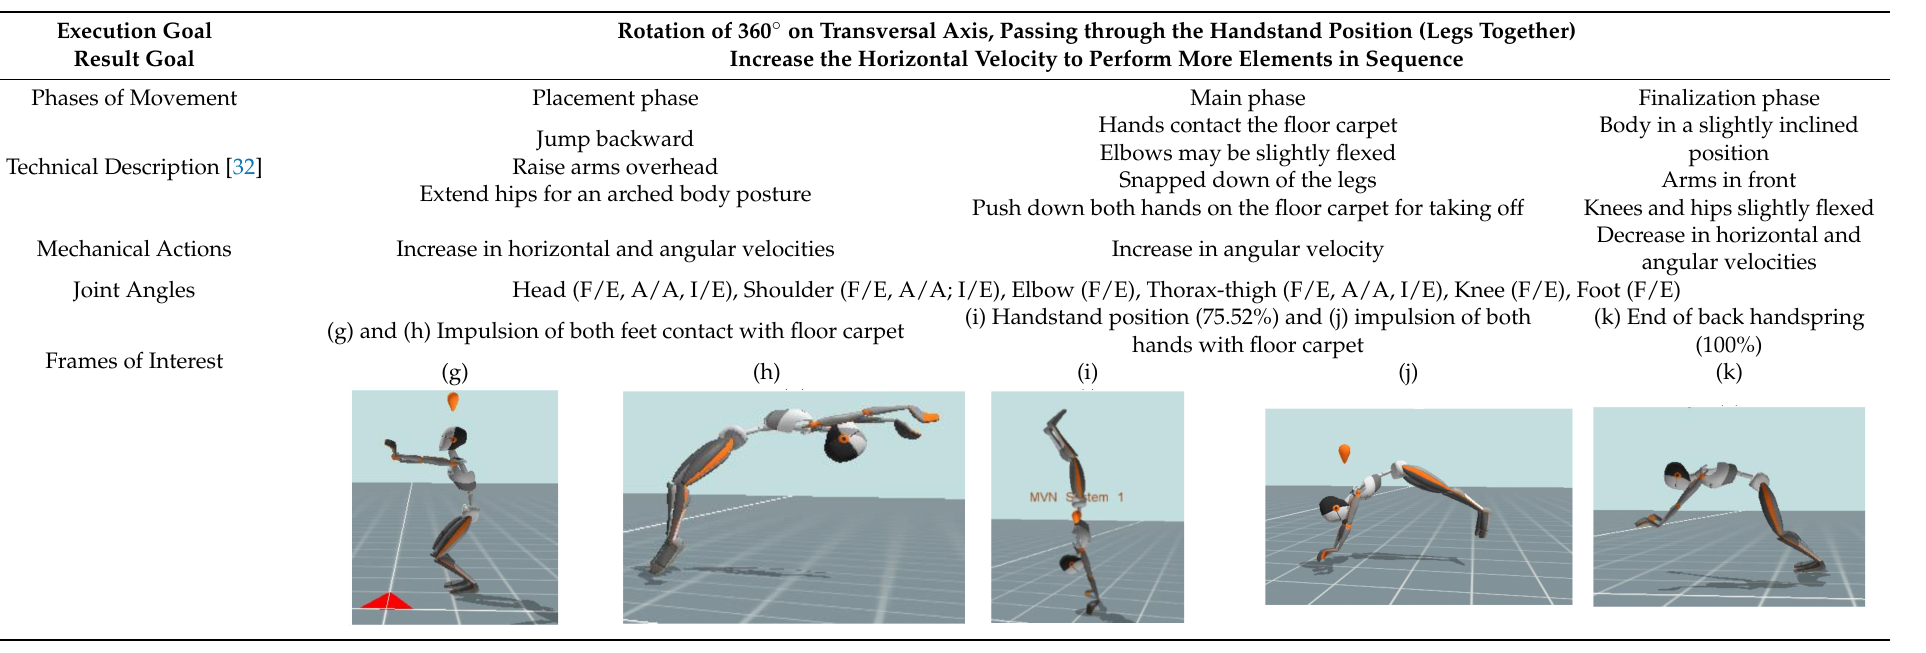
Table A3. Description of back handspring: goals, phases of movement, technical description, mechanical actions, segments angles and frames of